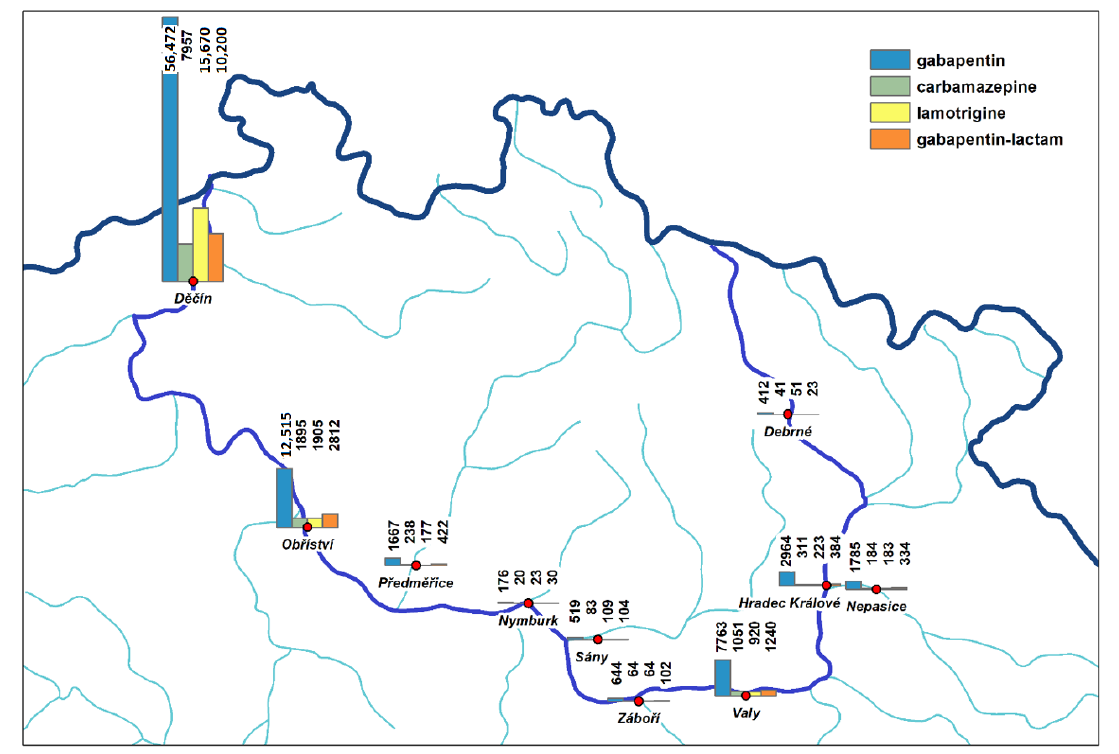
Figure 11. Median values of lamotrigine concentration at the sampled locations during the year 2021. Significant differences among the localities are indicated by different alphabetical superscripts ( p < 0.05).